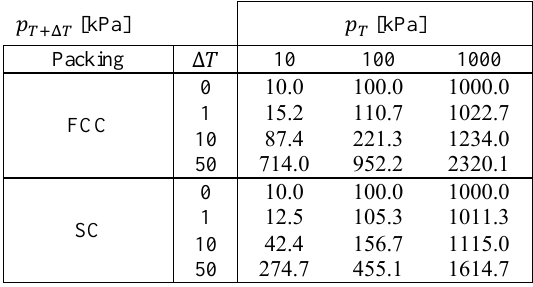
Table 2 . Analytical 𝑝 𝑇+Δ𝑇 values for the regular packings.